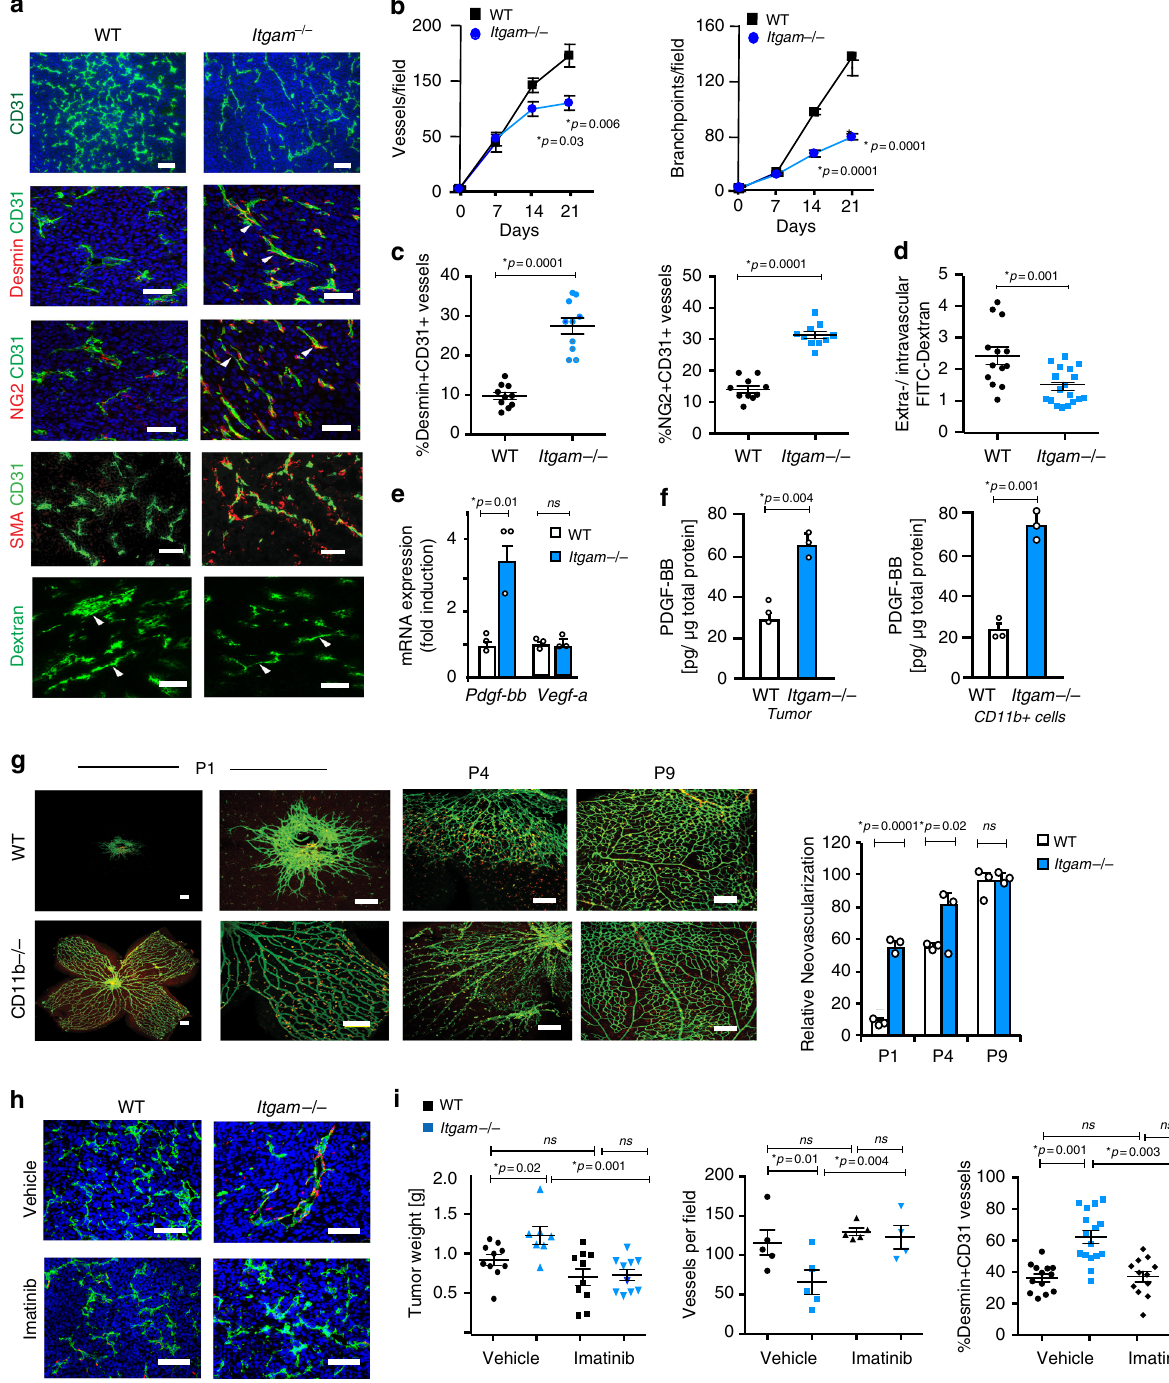
Fig. 2 CD11b suppresses PDGF-BB-dependent neovascularization and tumor growth. a CD31, Desmin, NG2, Smooth muscle actin (SMA) and Dextran immunostaining of blood vessels in LLC tumors from WT (white bars) and Itgam − / − (blue bars) mice ( n = 10). b Blood vessel density (vessels/ fi eld) and number of vessel branch points/ fi eld in LLC tumors from WT (white bars) and Itgam − / − (blue bars) animals ( n = 10). c Percent CD31 + /SMA + , CD31 + /Desmin + , CD31 + /NG2 + vessels in tumors from WT (white bars) and Itgam − / − (blue bars) ( n = 5). d Ratio of extravascular to intravascular FITC- dextran in LLC tumors from WT (white bars) and Itgam − / − (blue bars) mice ( n = 5). e , f Pdgfb and Vegfa e mRNA ( n = 3) and f PDGF-BB protein expression ( n = 12) in LLC tumors from WT (white bars) and Itgam − / − (blue bars) mice ( n = 3). g Left, FITC-Isolectin staining of whole mount retinas from newborn WT (white bars) and Itgam − / − (blue bars) mice. Right, Percent neovascularization at P1, P4, and P9 retinas in WT (white bars) and Itgam -/- (blue bars) mice ( n = 5). h Desmin (red) and CD31 (green) immunostaining of LLC tumors from Imatinib and vehicle-treated WT (white bars) and Itgam -/- (blue bars) mice. i Tumor weight, number of blood vessels/ fi eld and percent Desmin/CD31 vessels per fi eld from h ( n = 10). Bar on micrographs indicates 50 µ m. Error bars indicate sem. “ n ” indicates biological replicates. p < 0.05 indicates statistical signi fi cance, as determined by Student ’ s t -test for b – g and by Anova with Tukey ’ s post-hoc testing for i . Source data are provided in Source Data fi